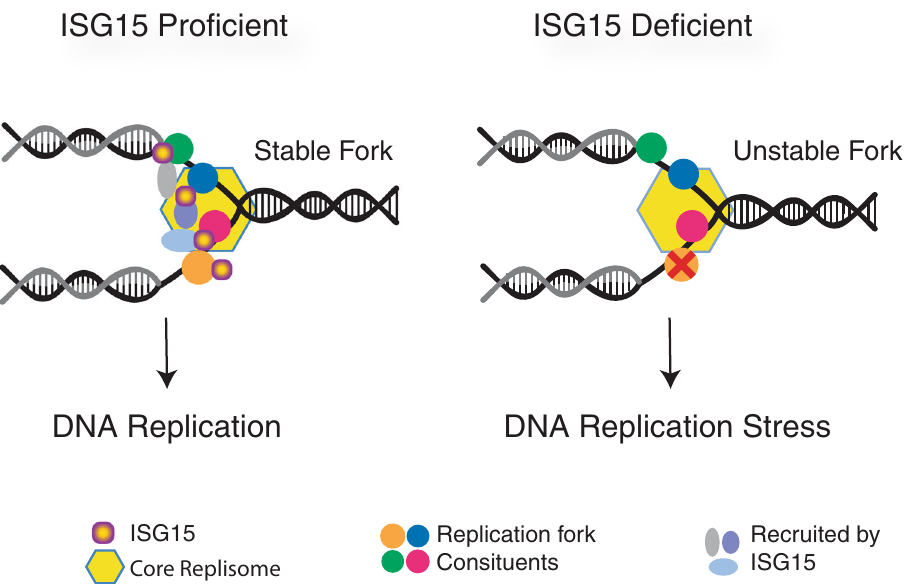
Fig. 6 | Model. Diagram predicting how ISG15 may be functioning at replication forks to maintain genomic stability. ISG15 pro fi cient cells: ISGylation stabilizes protein interactions and regulates protein functions at stalled replication forks, thus promoting faithful DNA replication. ISG15 de fi cient cells: No ISGylation of